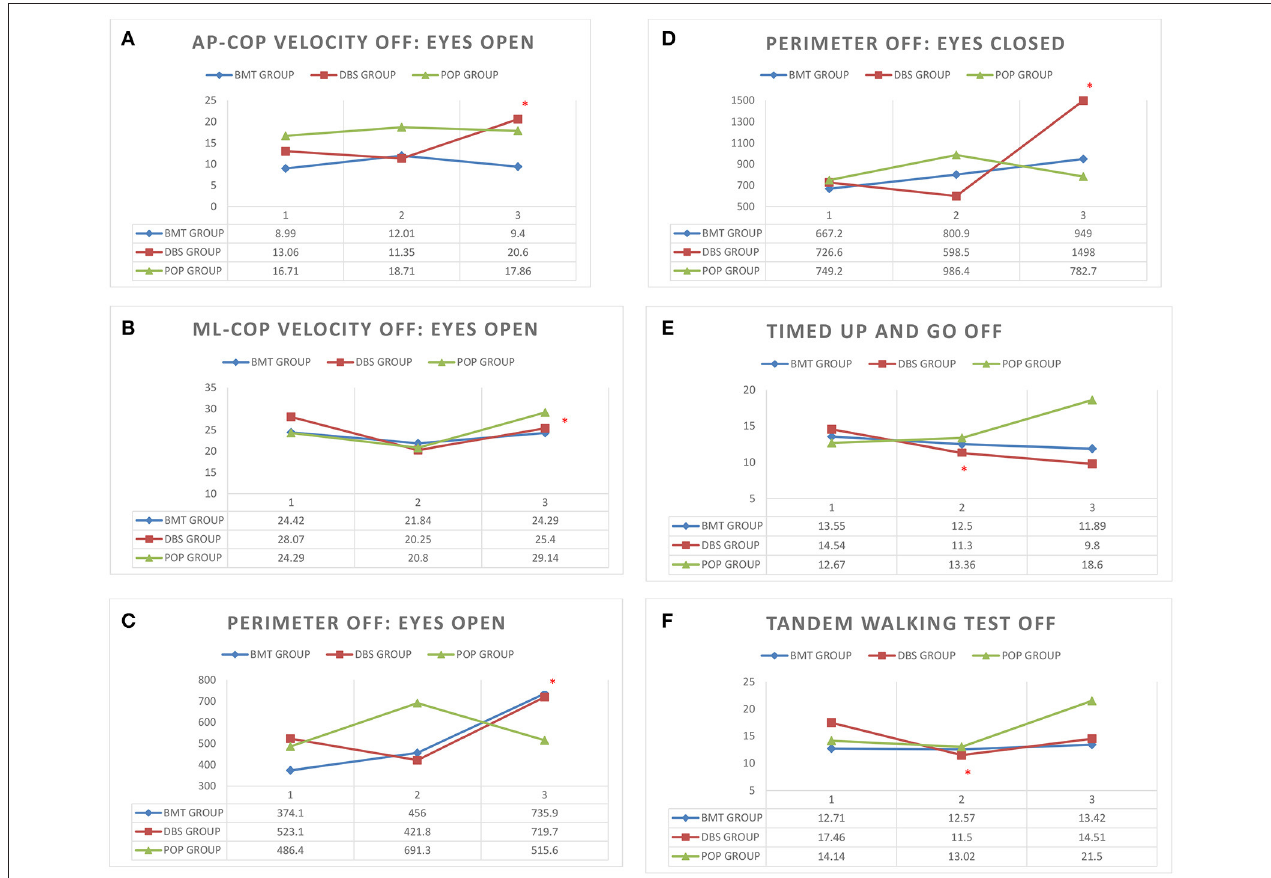
FIGURE 1 | (A–F) Posturography and clinical balance tests’ parameters in study groups (BMT, DBS, POP) in visits 1–3 (V1, V2, V3) * p < 0.05. (A) AP-CoP velocity (mm) with open eyes in Total-OFF phase in study groups (BMT, DBS, POP) in visits 1–3 (V1, V2, V3). (B) ML-CoP velocity (mm) with open eyes in Total-OFF phase in study groups (BMT, DBS, POP) in visits 1–3 (V1, V2, V3). (C) Perimeter (mm) with open eyes in Total-OFF phase in study groups (BMT, DBS, POP) in visits 1–3 (V1, V2, V3). (D) Perimeter (mm) with closed eyes in Total-OFF phase in study groups (BMT, DBS, POP) in visits 1–3 (V1, V2, V3). (E) Timed Up And Go test in Total-OFF phase in study groups (BMT, DBS, POP) in visits 1–3 (V1, V2, V3). (F) Tandem Walking Test in Total-OFF phase in study groups (BMT, DBS, POP) in visits 1–3 (V1 ,V2